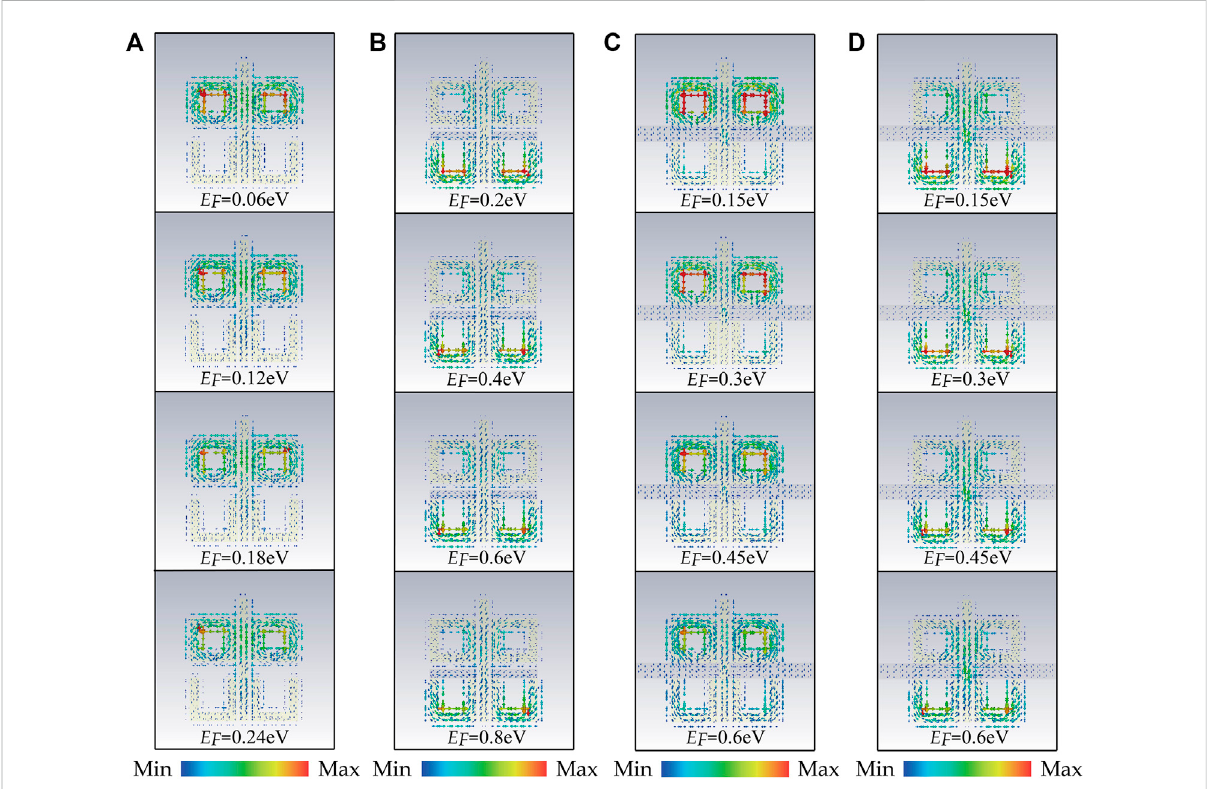
FIGURE 7 Surface current distributions of (A) D-EIT-g1 at the peak 1 frequency with E F varied from 0.06 to 0.24 eV, (B) D-EIT-g2 at the peak 2 frequency with E F variedfrom0.2to0.8 eV, (C) D-EIT-g12atthepeak1frequencywith E F variedfrom0.15to0.6 eV, (D) D-EIT-g12atthepeak2frequencywith E F varied from 0.15 to 0.6